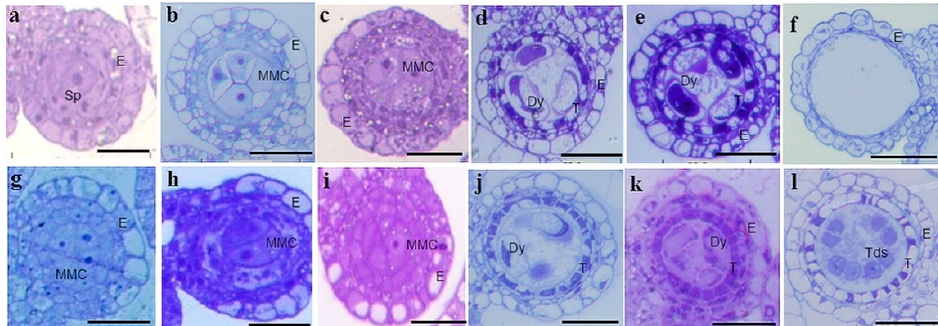
Figure 1. Cytological characterization of anthers. Anthers of IR68301S grown under sterile condition ( a – f ), anthers of IR68301S grown under fertile condition ( g – l ). E, epidermis; Sp, sporogenous cell; MMC, microspore mother cell; Dy, dyad cell; Tds, tetrads; Msp, microspore parietal cell. Bars = 20 µ m.